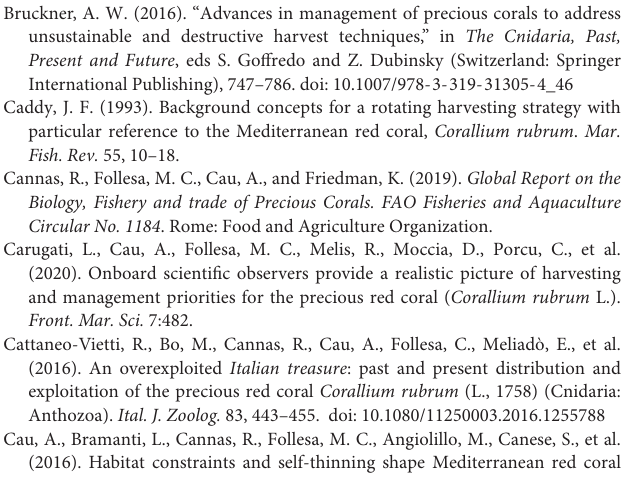
Supplementary Figure 1 | Annual deviation in the catch record between logbook and observer data (per trip) of the Taiwanese precious coral fishery between 2012 and 2018. (A) Box-whisker plot of the deviation (box range, first and third quartiles; band, median; whiskers, 1.5 interquartile; symbol, outliers), (B) mean (1 standard error) and median of the